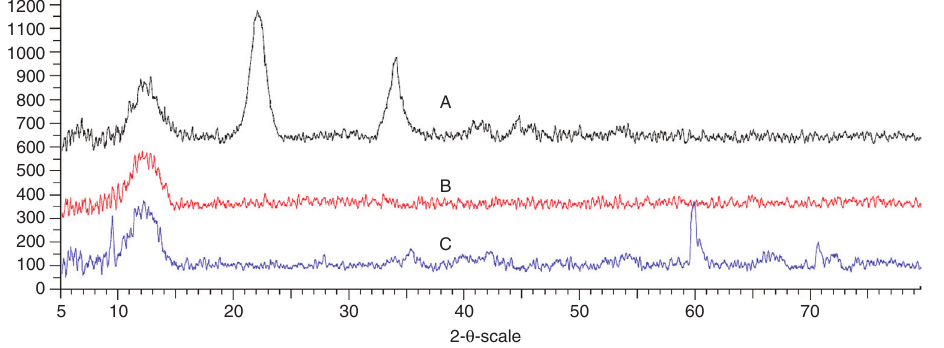
Figure 3 Comparison of different catalysts in terms of XRD analysis. (A) commercially available untreated cellulose, (B) catalyst obtained from hydrothermal carbonization followed by sulfonation of the commercially available cellulose, (C) catalyst prepared from waste paper pretreated with ultrasonically assisted alkaline pretreatment.